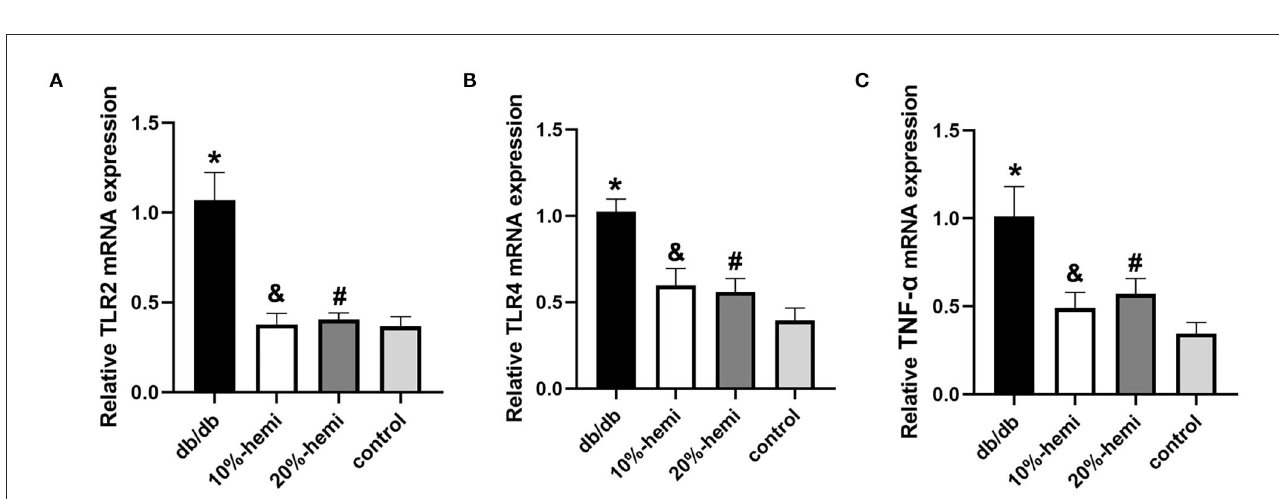
FIGURE7 Colonic inflammatory cytokine expression for the four groups (* db/db Vs. control, p < 0.01; &10%-hemi Vs. db/db, p < 0.01; # 20%-hemi Vs. db/db, p < 0.01).